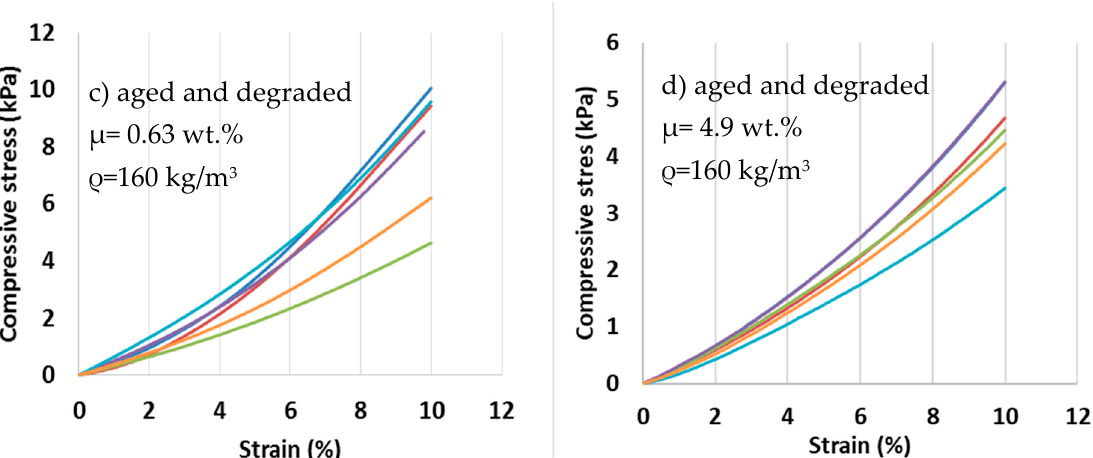
Figure 5. Compressive stress at 10% deformation.